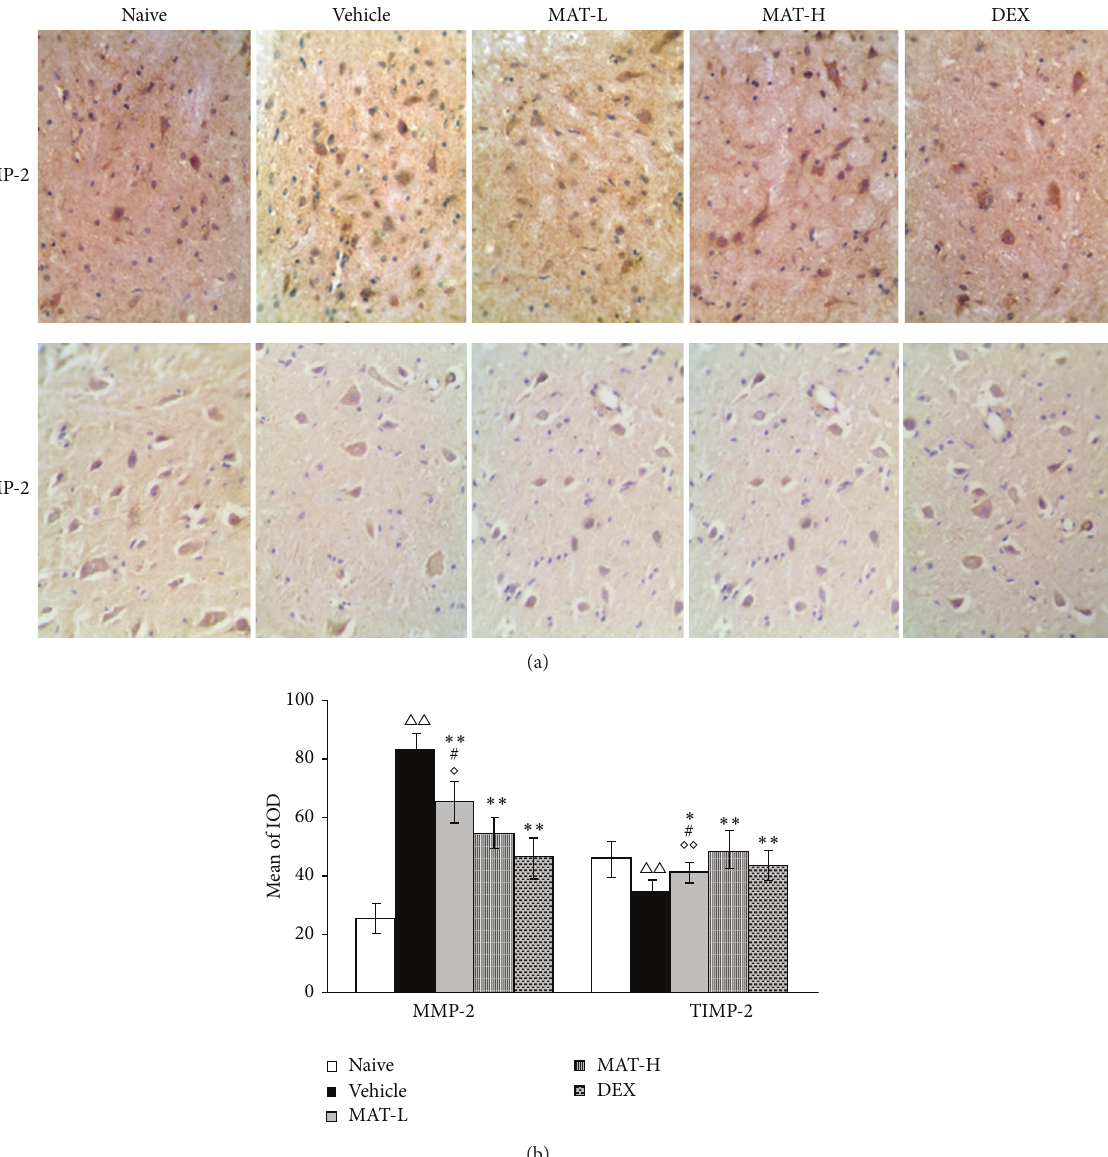
Figure 6: Immunohistochemistry of MMP-2 and TIMP-2. At day 17 p.i., spinal cords were harvested after extensive perfusion. (a) MMP-2 and TIMP-2 expression was determined by immunohistochemistry. Magnification: × 40. (b) Quantitative analyses. Values represent mean ± SD ( 𝑛 = 8 each group). △△ 𝑃 < 0.01 , compared to naive group; ∗ 𝑃 < 0.05 and ∗∗ 𝑃 < 0.01 , compared to the vehicle group; # 𝑃 < 0.05 , compared to the DEX group; ◊ 𝑃 < 0.05 , comparison between MAT-L and MAT-H